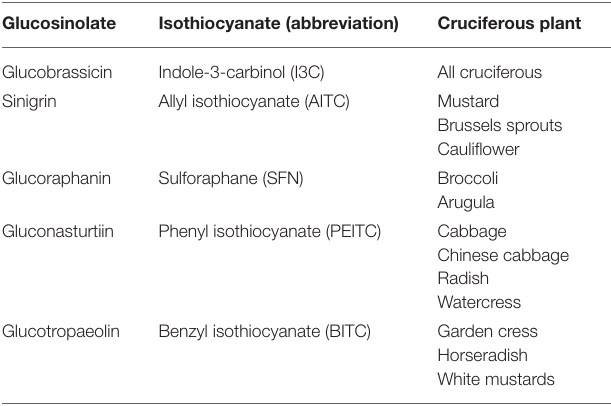
TABLE 1 | The most abundant and studied GSLs, their ITCs derivatives and representative cruciferous-where found.